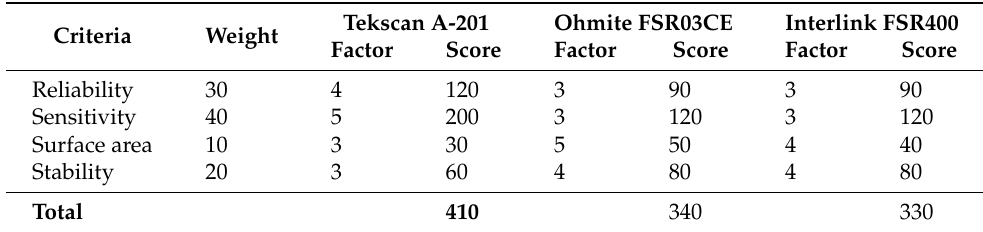
Table 1. Cost-benefit analysis for the choice of force-sensitive resistor (FSR). Weight: Importance of each criterion (out of a total of 100); Factor: Evaluation of the sensor’s ability to meet this criterion; Score: Score achieved by the sensor for a given criterion. Score = Weight ∗ Factor. Bold value indicates the best score.